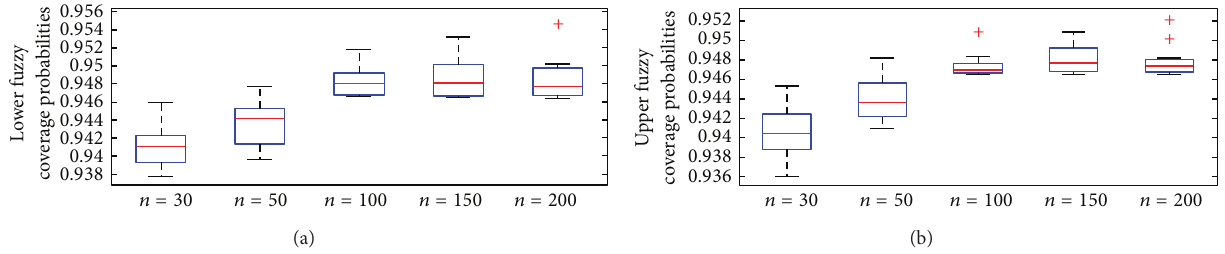
Figure 7: Boxplots of the lower and upper fuzzy coverage probability with sample size 𝑛 = 30, 50, 100, 150 , and 200 at significance level 95